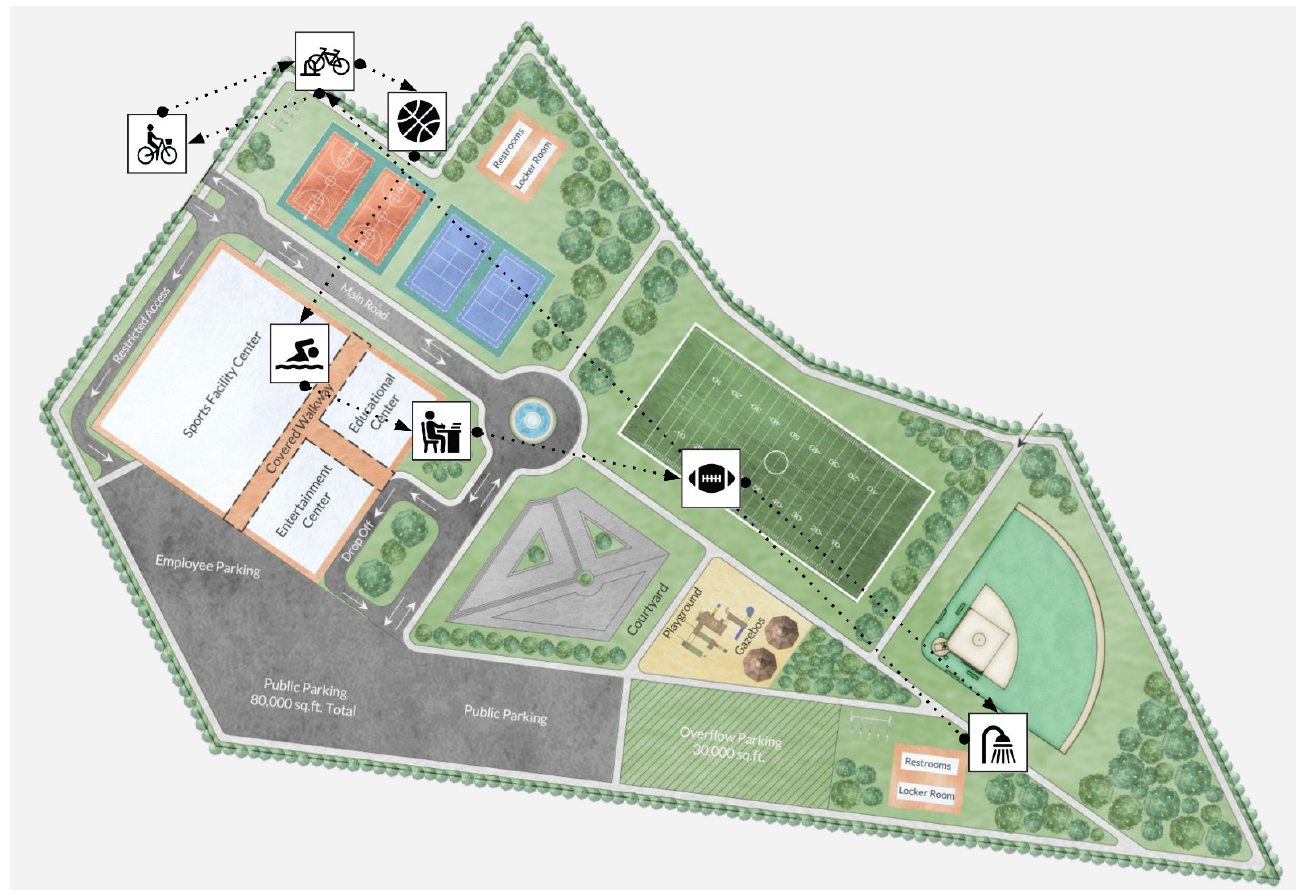
Figure 10. An example of an MBP (+ educational facilities) concept map with access to an MMS (arrows indicate proposed MMS access and circulation).